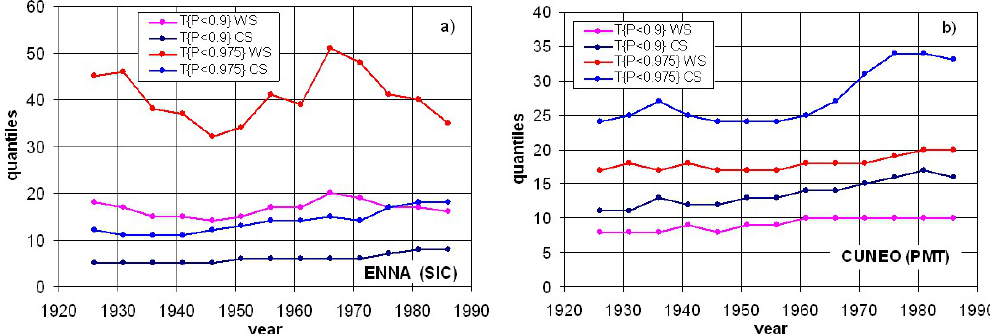
Figure 6. Time-series of two high quantiles T { P < 0 . 9 } and T { P < 0 . 975 } , estimated by polylog-series distribution, for both season and for two sites: (a) Enna station (SIC) and (b) Cuneo station (PMT).